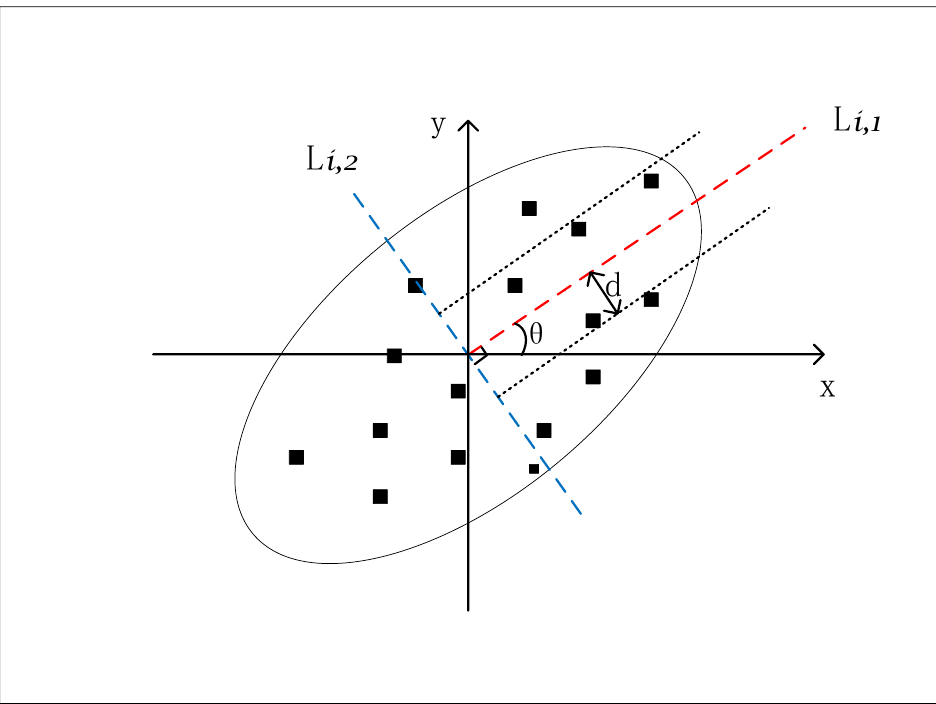
Figure 5. Calculation of the control points . Squares are the measurements.